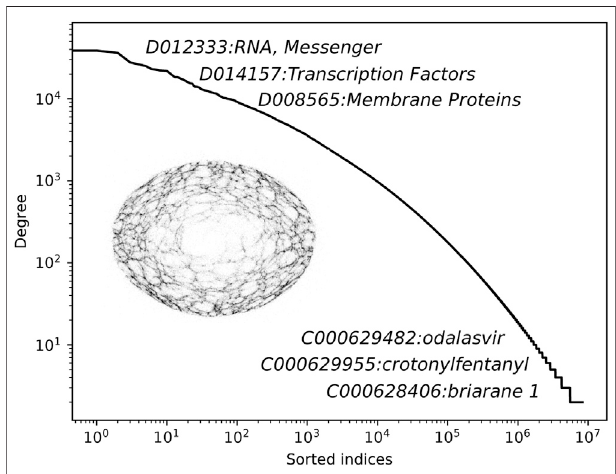
FIGURE3| Thedegreedistributionoftheconstructed CHEMMESHNET with some of the representative annotations. Note that for the purpose of this study, the constructed CHEMMESHNET consists only of MeSH terms, annotated as chemicals .